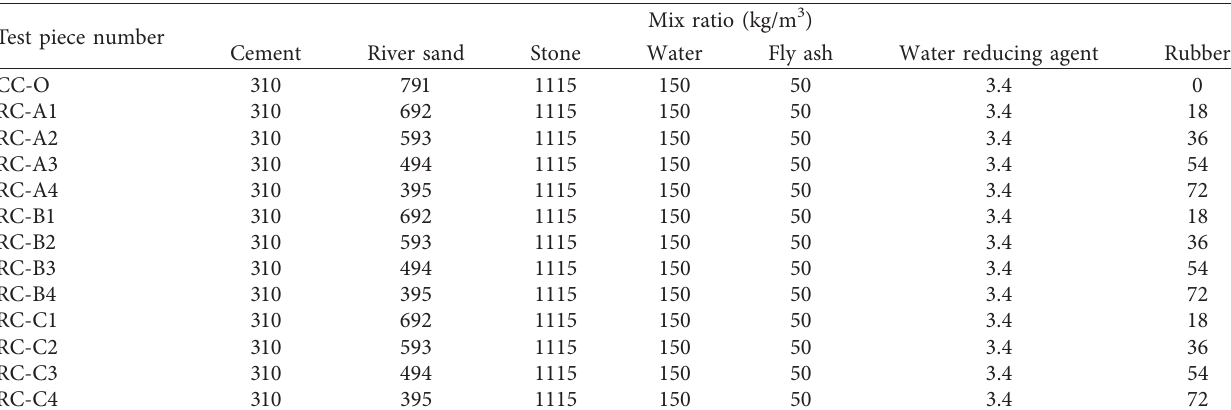
Figure 1: XRD analysis of cement and fly ash: (a) diffraction analysis of cement and (b) diffraction analysis of fly ash. Table 1: Specimen mix